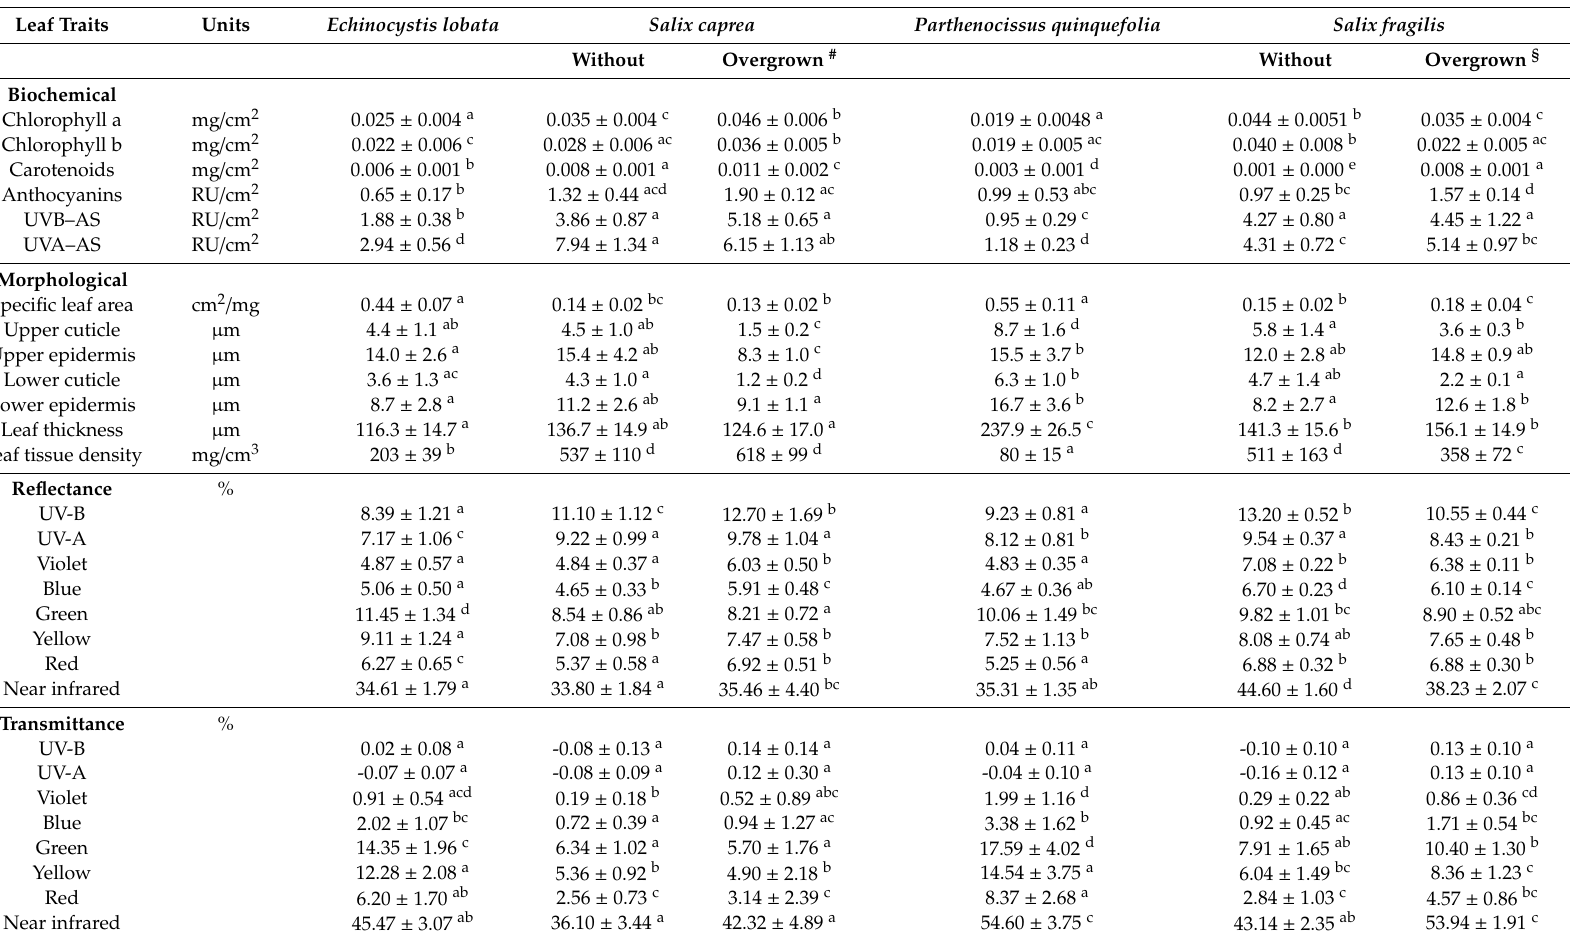
Table 2. Leaf traits of the vines and the willows growing without vines and overgrown with